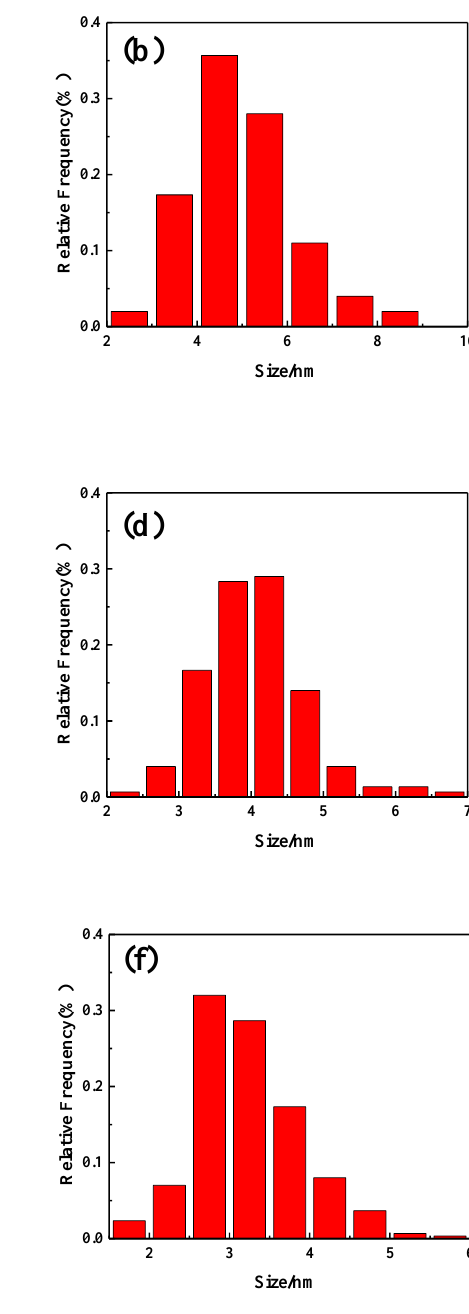
Figure 4. TEM images (ED–TD plane) and size distribution histogram of precipitates in alloys with different Zn/Mg ratios: ( a , d ) 1# alloy; ( b , e ) 2# alloy; ( c , f ) 3# alloy. STEM (Scanning transmission electron microscope) images of the grain boundary precipitates (GBP S ) in alloys with different Zn/Mg ratios are shown in Figure 5. The white and thick η phases precipitated on the grain boundary. In Figure 5, the width of precipitates free zone (PFZ) around grain boundaries was not obviously different for different Zn/Mg ratios. However, the GBPs became coarse with the decrease of the Zn/Mg ratio. When the Zn/Mg ratio was 11.4, the GBP S were dense and continuously distributed. The GBPs became discontinuous distribution when the Zn/Mg ratio decreased to 8.1. When the Zn/Mg ratio was further decreased to 6.1, the GBP S became interrupted distributed and the gap between GBP S became larger. Results indicated that with the decrease of the Zn/Mg ratio, the gap between the GBP S gradually became larger and the continuous distribution state changed to discontinuous distribution.